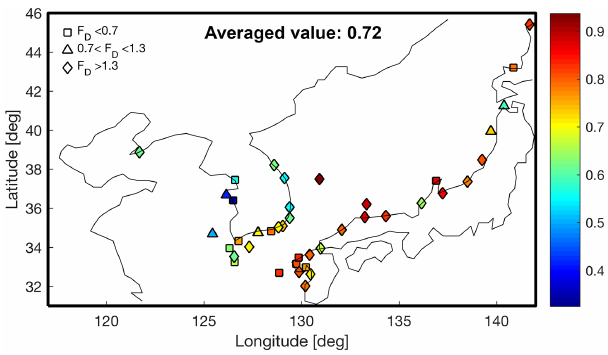
Figure 4. Linear trends comparison (shapes) and correlation coeffi- cients (colors) between tide gauge and the closest AVISO grid point (<12km) from 1993 to 2014, where F D = SLR TG / SLR AVISO (without annual